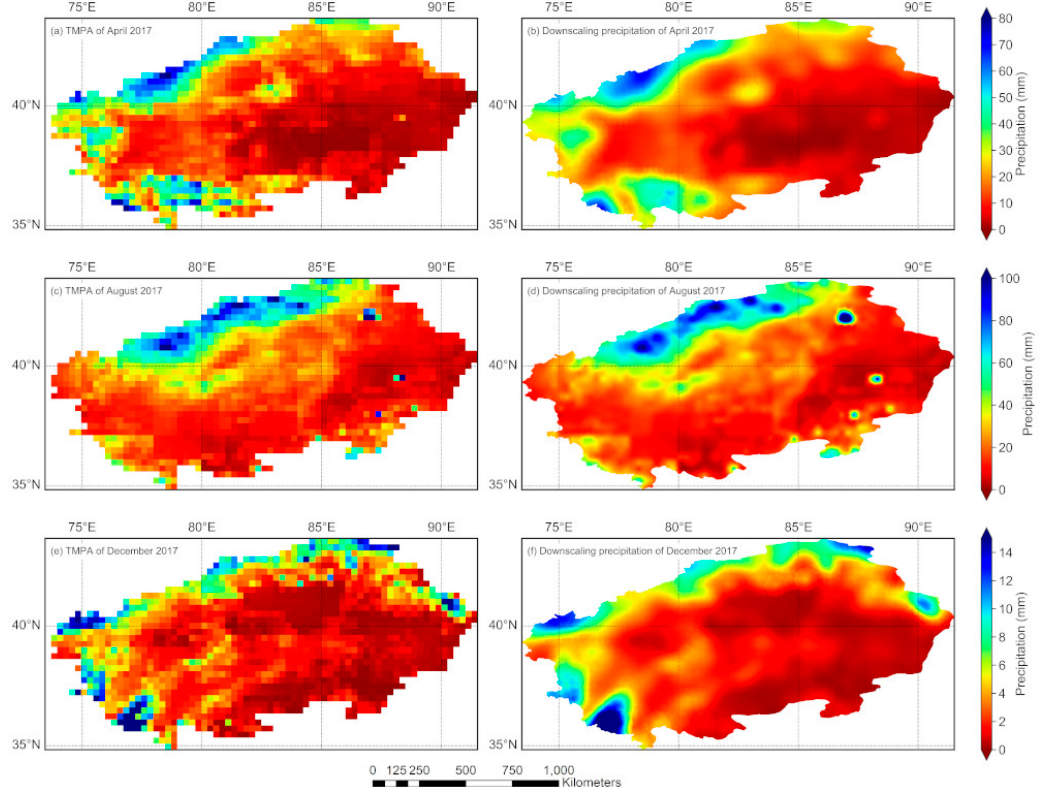
Figure 8. The comparison of TMPA data (left) and downscaling precipitation (right). ( a , c , e ) represent the TMPA data of April, August, and December of 2017, respectively; ( b , d , f ) represent the downscaling precipitation of corresponding time.